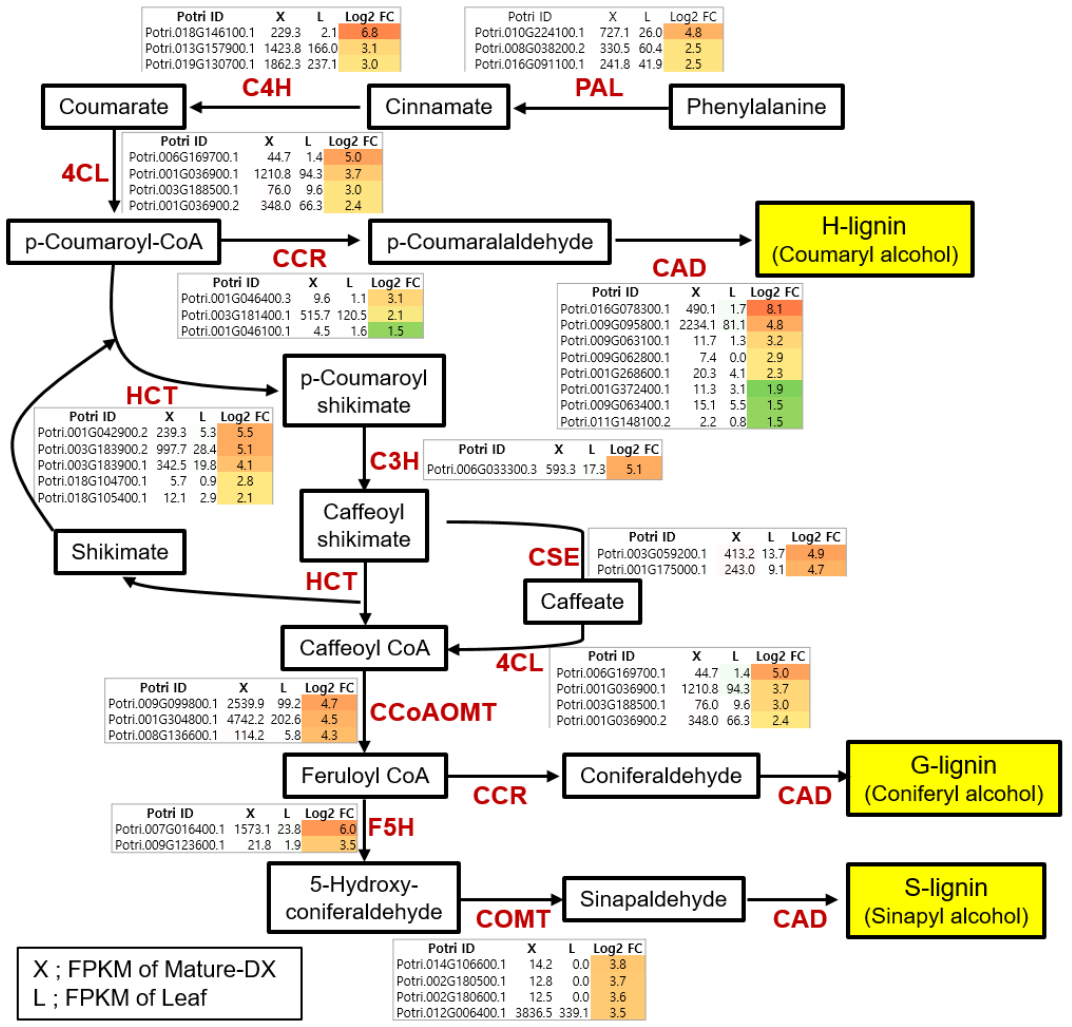
Figure 4. Identification of major players of the monolignol biosynthetic pathway in secondary wall formation. Metabolites in each step of the biosynthetic pathway are shown in the box and all the related genes are shown to the side. Fold changes (X/L) were calculated in Log2. X is a FPKM value of mature developing xylem (MDX) and L is the leaf FPKM value. Color gradient according to fold change values was visualized.